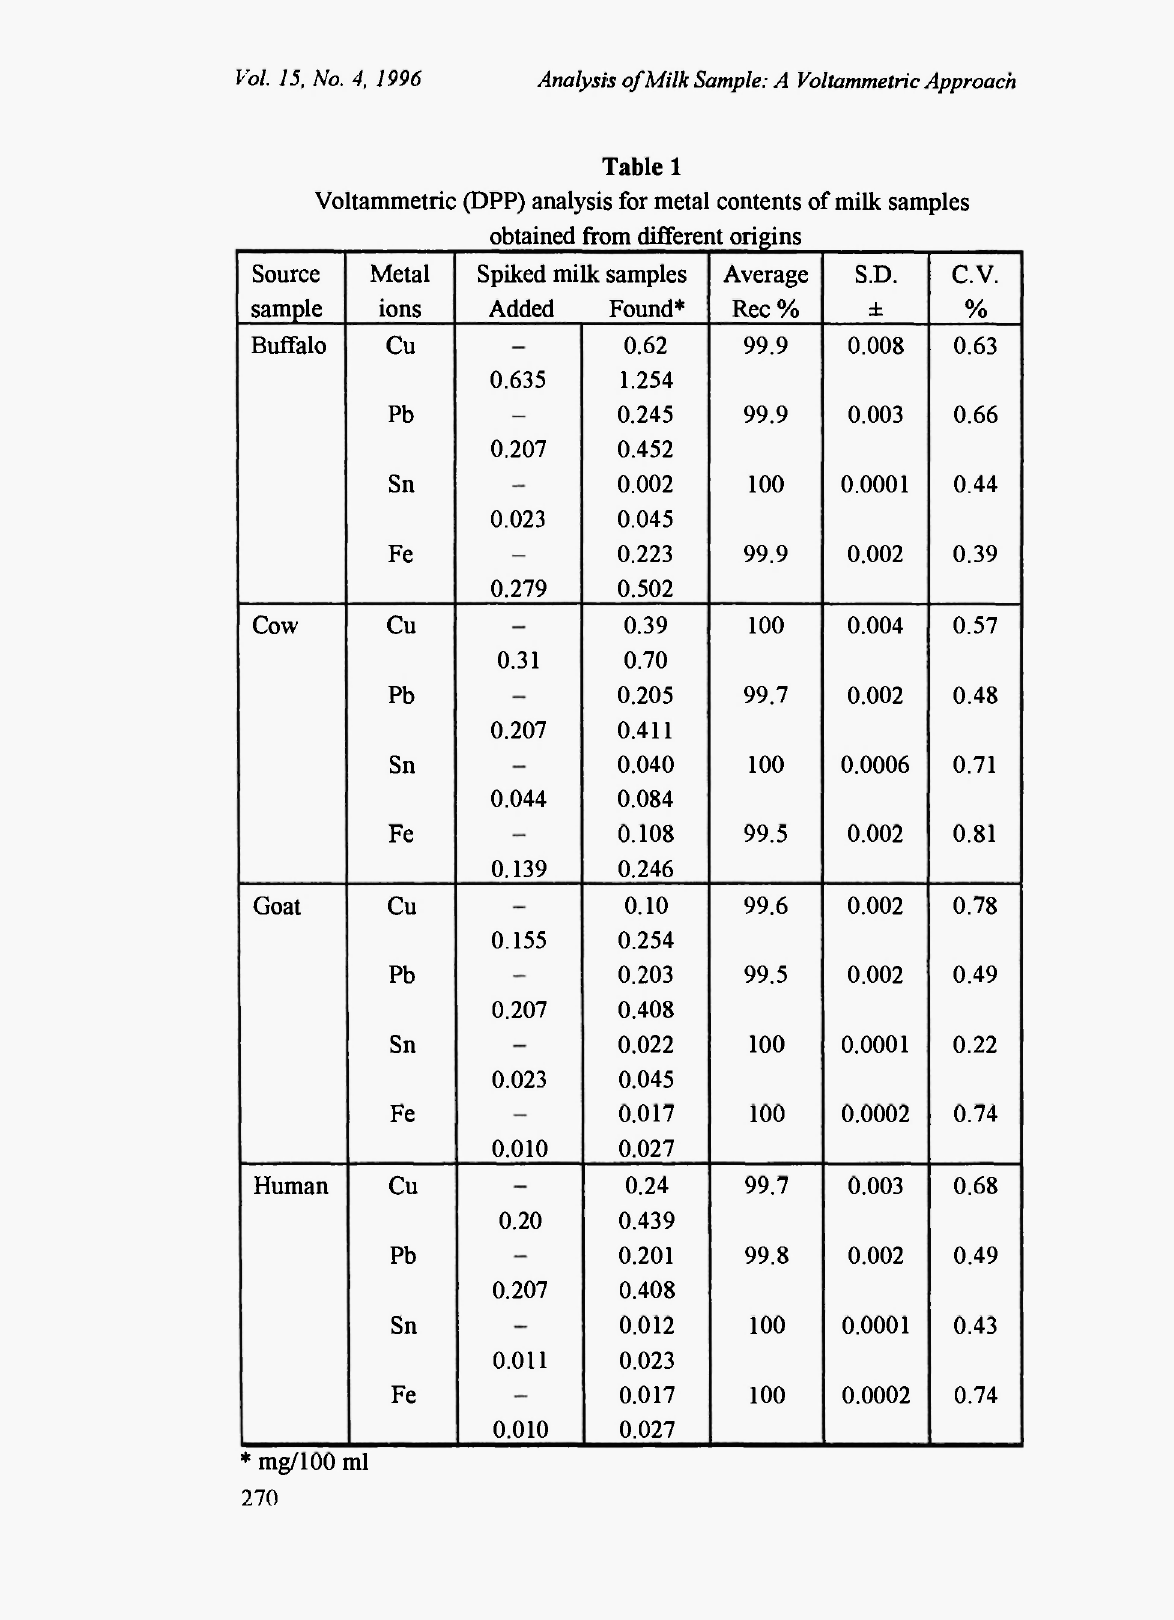
Voltammetric (DPP) analysis for metal contents of milk samples obtained from different